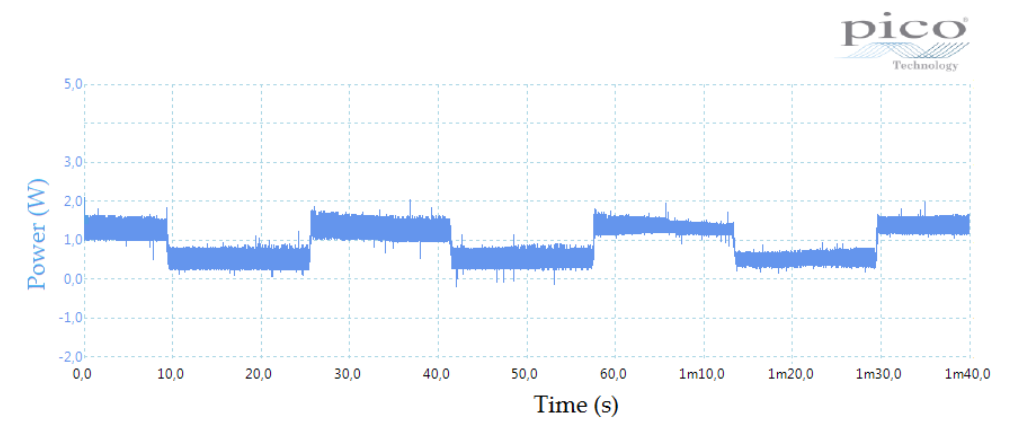
Figure 16. Power generated by employing the P&O